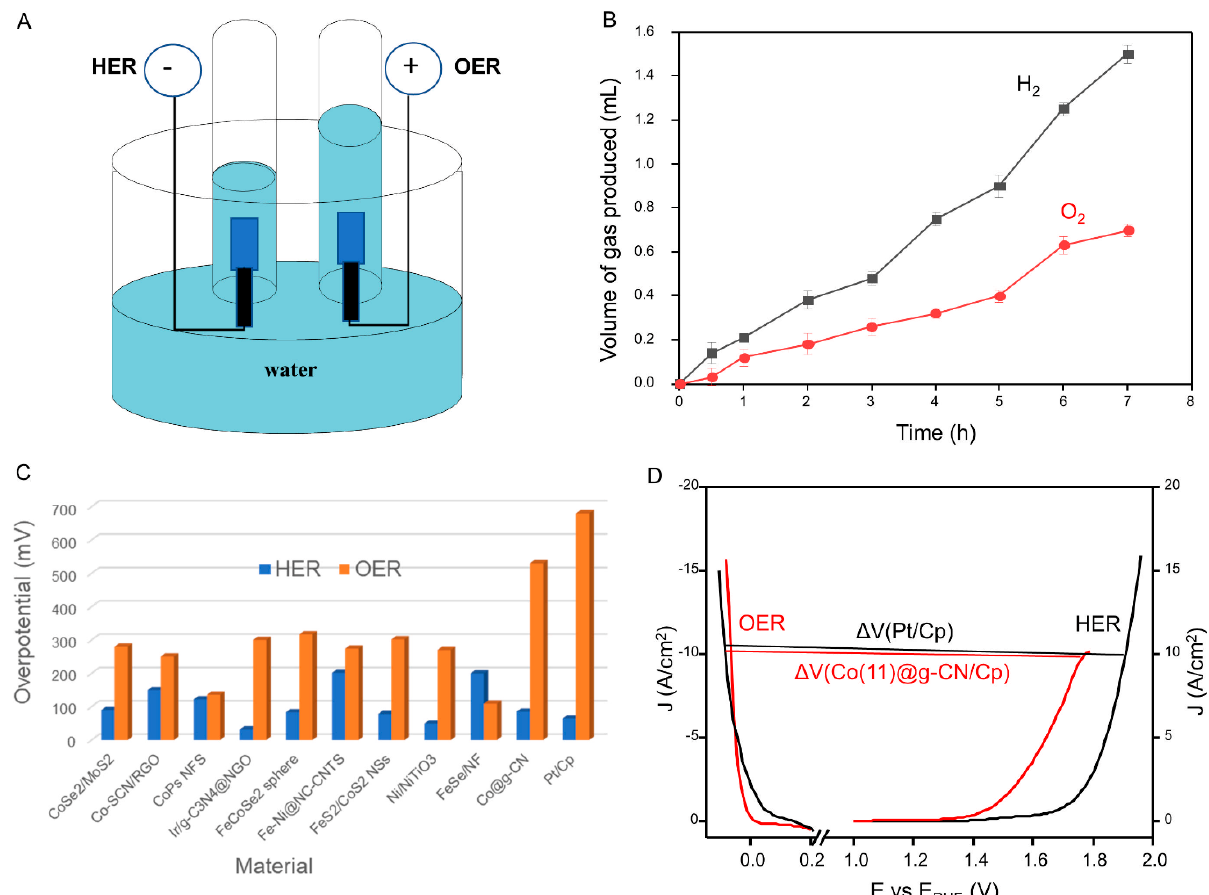
Figure 7. ( A ) A setup for the quantification of H 2 and O 2 gases by a downward displacement of water, ( B ) volumes of H 2 and O 2 gases evolved over time, ( C ) overpotentials of HER and OER from the current work and previous reports, and ( D ) overall water-splitting overpotential of Co(11)@g-CN (red) and Pt/Cp (black). Table 3. Parameters of electrochemical water splitting by bifunction catalysts.